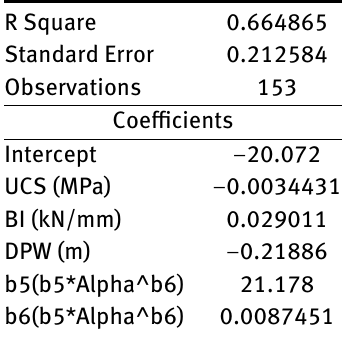
Table 6: Nonlinear regression model with exponential DPW and